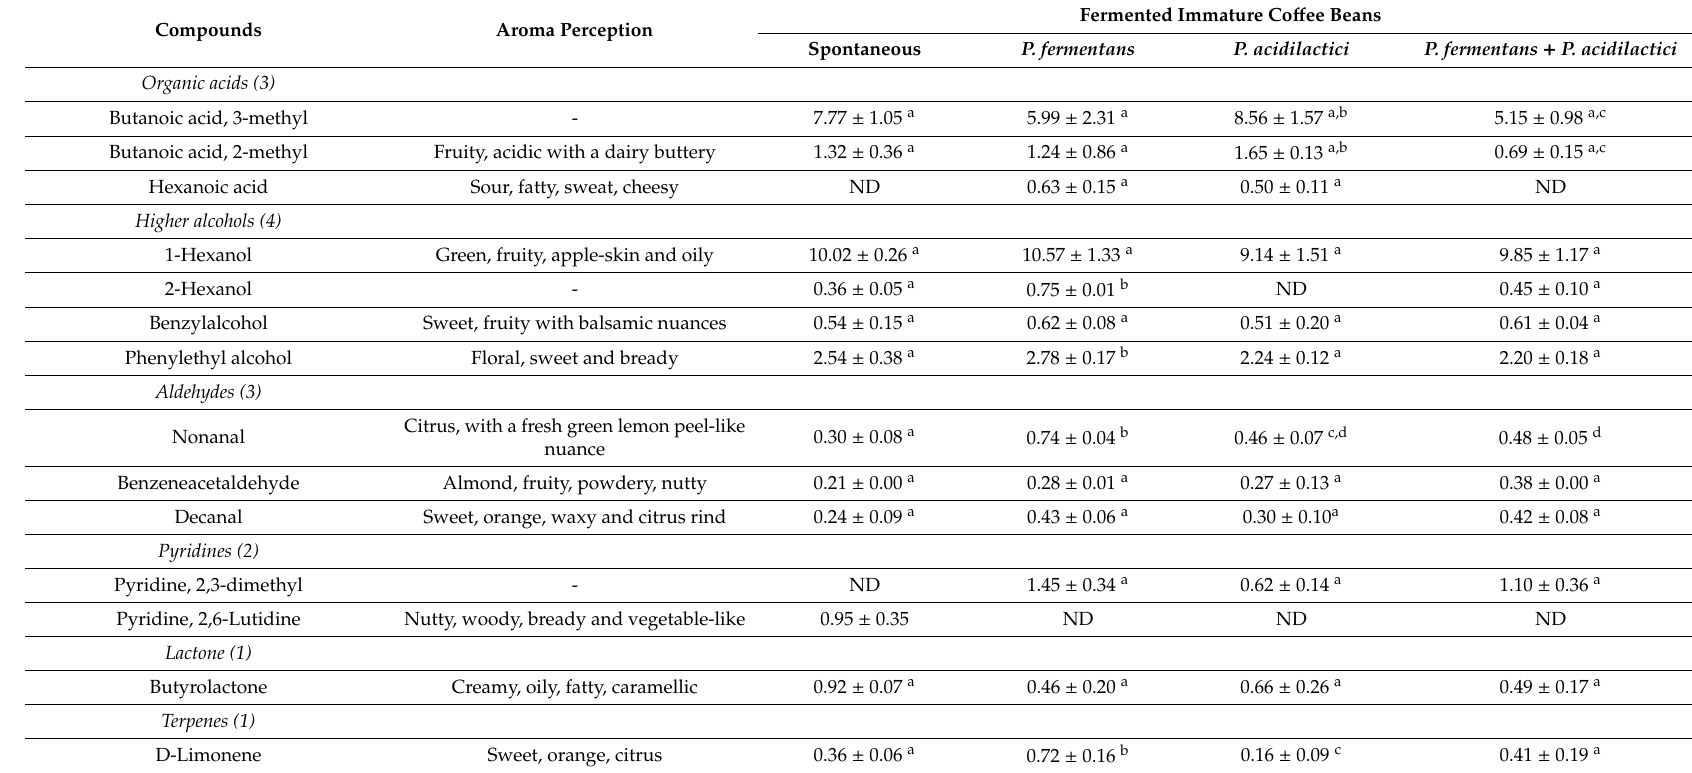
Table 2. Concentration of volatile compounds (Area*10 5 ) in immature co ff ee beans after single cultures, a combined treatment, and a spontaneous assay. Means of triplicate in each row bearing the same lowercase letters (a, b, c) are not significantly di ff erent ( p > 0.05) from one another using Duncan’s Test (mean ± standard